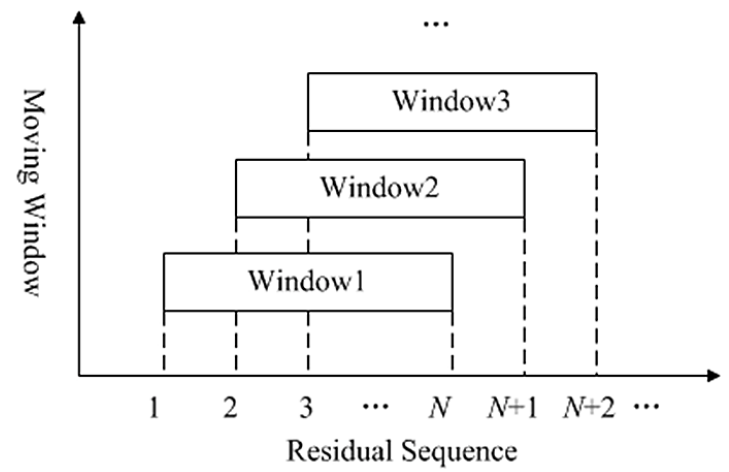
Figure 6. Residual moving average window used in residual